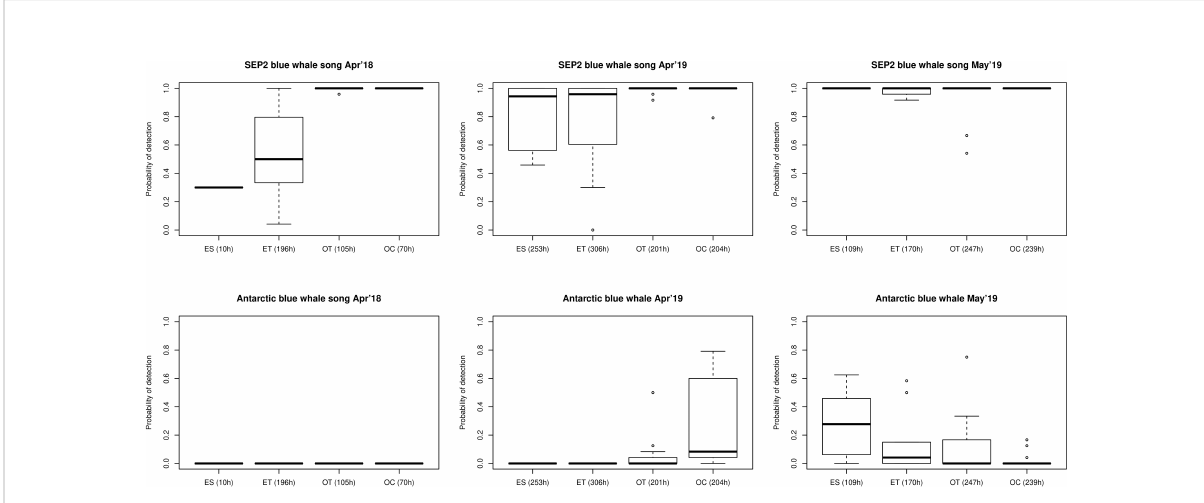
FIGURE 4 Boxplots of percentage of day with presence of SEP2 and Antarctic blue whale songs, blue whales D-calls and sei whale calls, per study period and per oceanographic zone. First column: April 2018 (deployment 1); Second column: April 2019 (deployment 2 and 3); Third column: May 2019 (deployment 4). ES, Estuarine zone; ET, Estuarine Transition zone; OT, Oceanic Transition zone; OC, Oceanic zone. For each zone, the number of hours that the glider was in the zone in indicated in the x-axis labels.